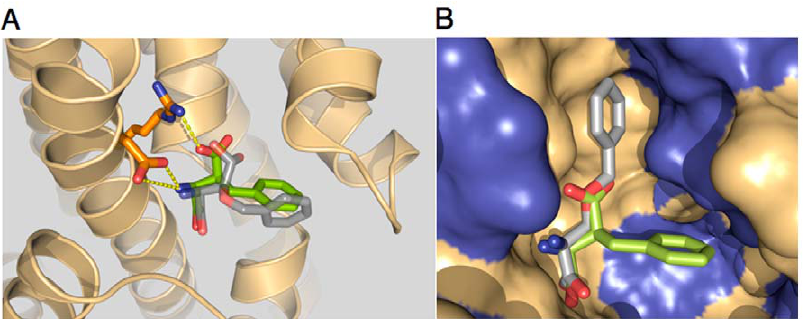
Figure 1. Interaction of L-TBA with EAATs. (A) Docking of L-TBA (green) and L-TBOA (gray) in EAAT3 model showing overlap of functional groups interacting with R447 and D444, with benzyl groups oriented toward extracellular loop HP2 as described in [14]. (B) Surface depiction of the transporter binding site (hydrophobic regions blue) showing L-TBA and alternate docking orientation of L-TBOA with benzyl ring aligned in alternate hydrophobic pocket.